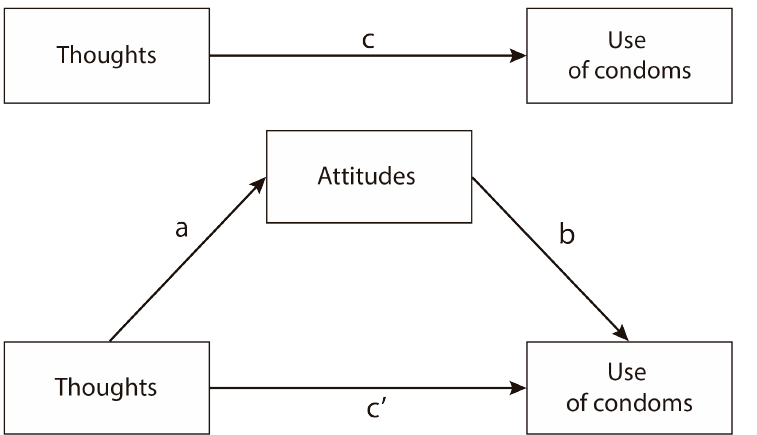
Figure 1. Hypothesis mediation model for thoughts, attitudes, and use of condoms. Thoughts: predictor variable, attitudes: mediator, use of condoms: outcome